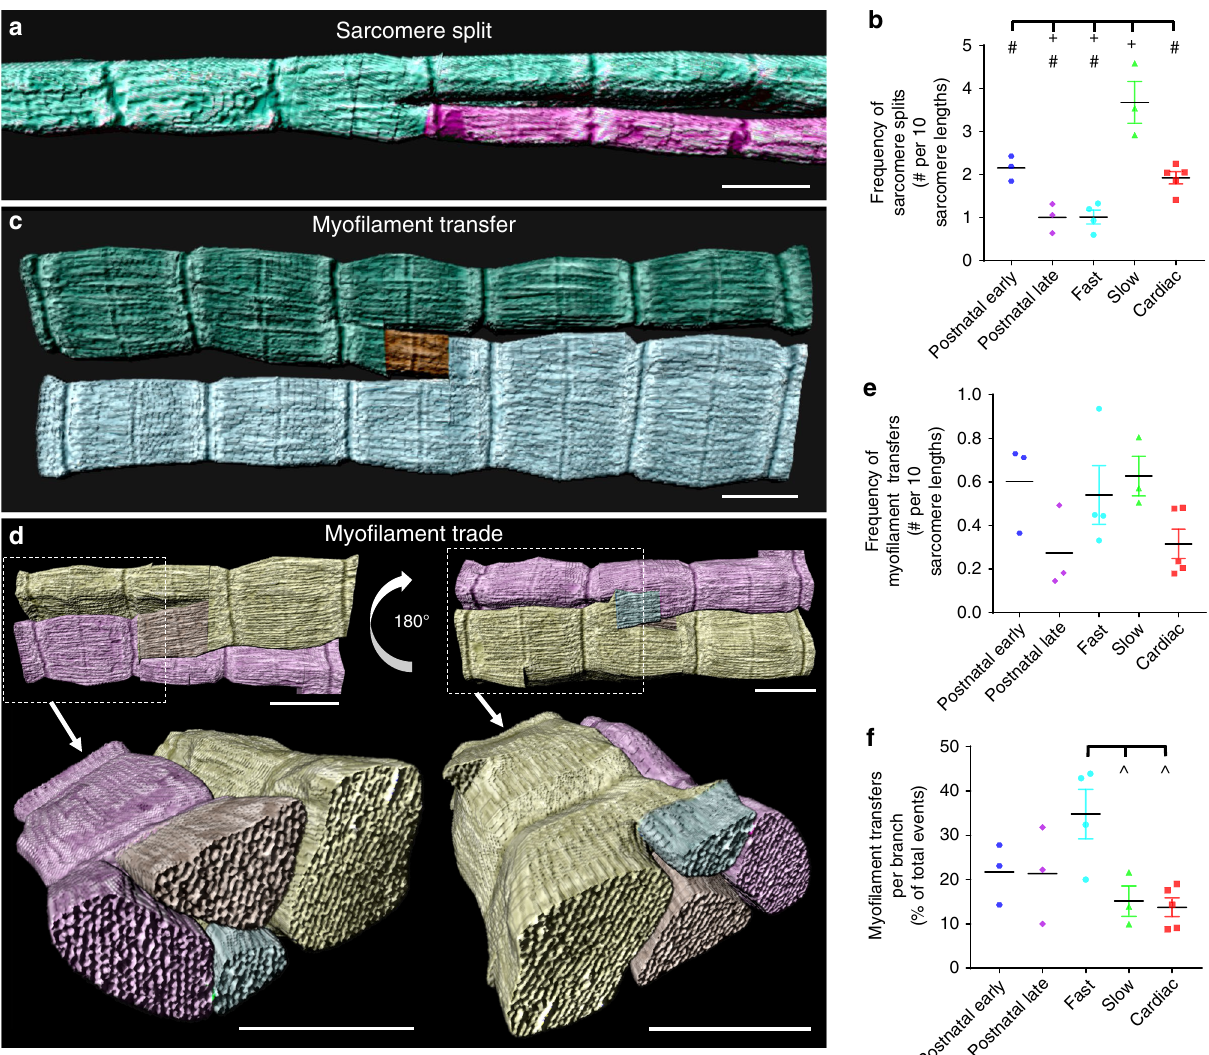
Fig. 3 Types of sarcomere branching. a 3D rendering of a sarcomere split. Individual colors represent different myo fi brillar segments linked by branching sarcomeres. Representative of 1766 splits, 18 muscles, 16 mice. b Frequency of sarcomere splits. c 3D rendering of a transfer of myo fi laments from one sarcomere to another. d 3D renderings of a transfer where myo fi laments are traded between two sarcomeres. c , d are representative of 525 transfers, 18 muscles, 16 mice. e Frequency of myo fi lament transfers. f Percentage of myo fi lament transfers relative to total sarcomere branches. N values for b , e , f : postnatal early — 141 myo fi brils, 1796 sarcomeres, 3 muscles, 3 mice; postnatal late — 150 myo fi brils, 1401 sarcomeres, 3 muscles, 3 mice; fast twitch — 193 myo fi brils, 3477 sarcomeres, 4 muscles, 3 mice; slow twitch — 110 myo fi brils, 1396 sarcomeres, 3 muscles, 3 mice; cardiac — 167 myo fi brils, 2114 sarcomeres, 5 muscles, 5 mice. Plus ( + ): Signi fi cantly different (one-way ANOVA, P < 0.05) from postnatal early. Pound sign (#): Signi fi cantly different from slow. Up arrow (^): Signi fi cantly different from fast. Scale bars, 1 µ m. Values: mean ±